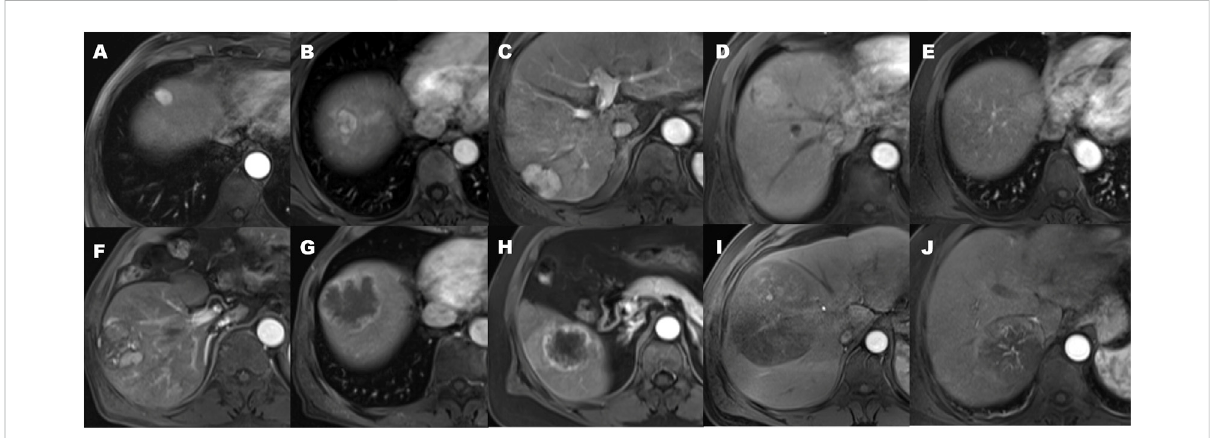
FIGURE 2 The patterns of arterial phase enhancement of hepatocellular carcinoma on contrast-enhanced MRI. (A) Homogeneously hypervascular HCC. (B) Hypervascular HCC with slit-like hypovascular foci. (C) With multifocal hypovascular foci. (D) Hypervascular HCC with the peripheral hypovascular area. (E) Completely isovascular HCC. (F) HCC with a nodular or irregular-shaped hypovascular portion at the inner area. (G) Hypovascular HCC with irregular rim-like enhancement. (H) Hypovascular HCC with the peripheral hypervascular area, discontinuous rim or crescent-like, and the presence of peritumoral enhancement seen in the arterial phase. (I) Hypovascular HCC with linear or spot-like hypervascular foci. (J) the presence of an intratumoral